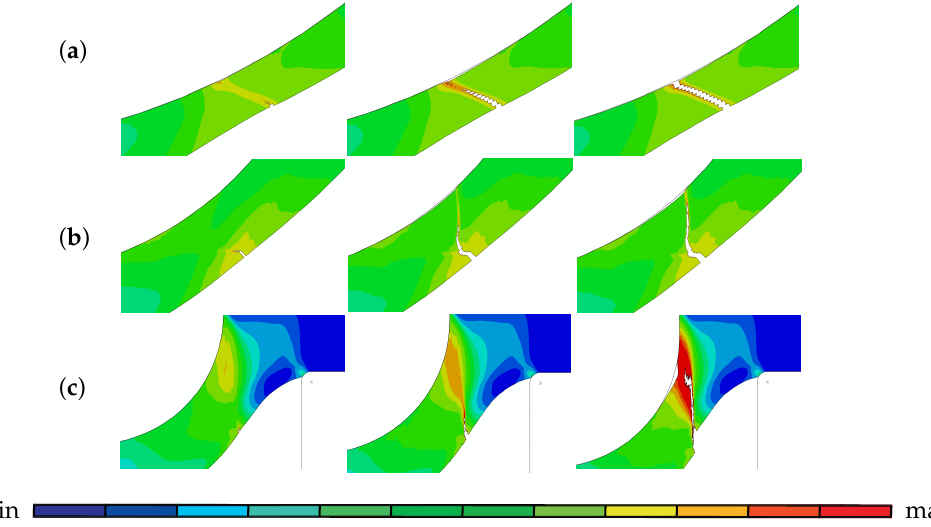
min max Figure 8. Initiation and propagation of the crack along the maximum plastic strain for disks with thicknesses of ( a ) 0.2 mm ( b ) 0.5 mm ( c ) 1 mm. For all cases min = 0, max =